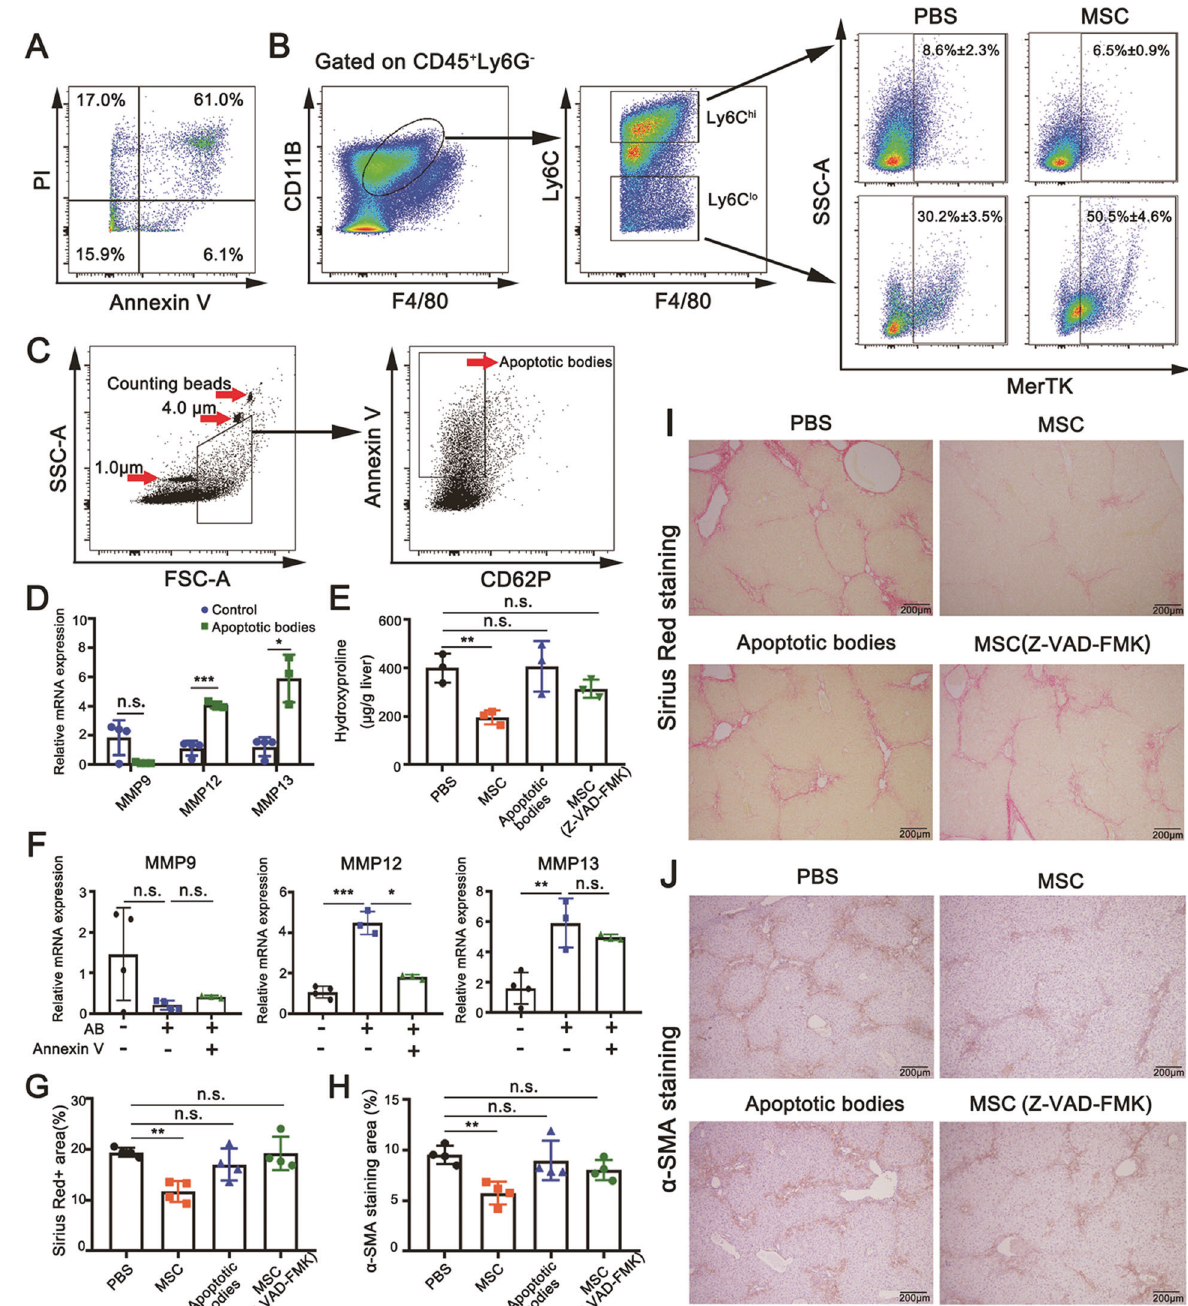
Fig. 6 Examination of the engulfment of BM-MSC-derived apoptotic bodies by Ly6C lo macrophages. A FCM analysis for apoptotic BM- MSCs induced by 50% ILCM (v/v) for 24 h through Annexin V and PI staining. B Representative FCM gating strategy used to identify differential MerTK expression in CD11b hi F4/80 int Ly6C hi and Ly6C lo macrophages in the fi brotic liver after transplanting 1 × 10 6 BM-MSCs or PBS control ( n = 3). C Quanti fi cation of apoptotic bodies by FCM analysis. Calibration beads with diameters of 1.0 and 4.0 μ m (internal reference beads) and counting beads with diameters of 7.0 μ m were used to gate 1 – 5 μ m-sized microvesicles. Apoptotic bodies were identi fi ed as AnnexinV + P62 − . D Quantitative real-time PCR analysis for the transcriptional expression levels of matrix-degrading relevant mmp9 , mmp12 , and mmp13 genes in BMDMs (1 × 10 6 ) with engulfment of apoptotic bodies (3 × 10 7 ) for 12 h ( n = 3 and n = 4). E Quanti fi cation of the hydroxyproline content in livers after transplantation with PBS (control), BM-MSCs, BM-MSC-derived apoptotic bodies, and BM-MSCs pretreated with Z-VAD-FMK (40 μ M) ( n = 3). F Quantitative real-time PCR analysis for the transcriptional expression levels of mmp9 , mmp12 , and mmp13 genes in BMDMs with engulfment of apoptotic bodies pretreated with Annexin V (1 μ g/mL) for 12 h ( n = 3 and n = 4). G , I Examination of the degree of liver fi brosis by staining tissue sections with Sirius Red ( I ) and semi-quanti fi cation through Image software ( G ) after mice were transplanted with PBS (control), BM-MSCs (1 × 10 6 ), BM-MSC-derived apoptotic bodies (3 × 10 7 ), and BM-MSCs (1 × 10 6 ) pretreated with Z-VAD-FMK (40 μ M) ( n = 4). Scale bars, 200 μ m. H , J Immunohistochemistry staining ( J ) and semi-quanti fi cation ( H ) of α -SMA in each group ( J ). The α -SMA + areas were quanti fi ed from fi ve random non-overlapping fi elds of each sample ( n = 4). Scale bars, 200 μ m. Bars = means ± SD. Statistical evaluation of two groups was performed using the independent Student t- test. Statistical evaluation of multiple groups was performed using one-way ANOVA with posthoc LSD test; n.s. p > 0.05, * p < 0.05, ** p < 0.01, *** p <